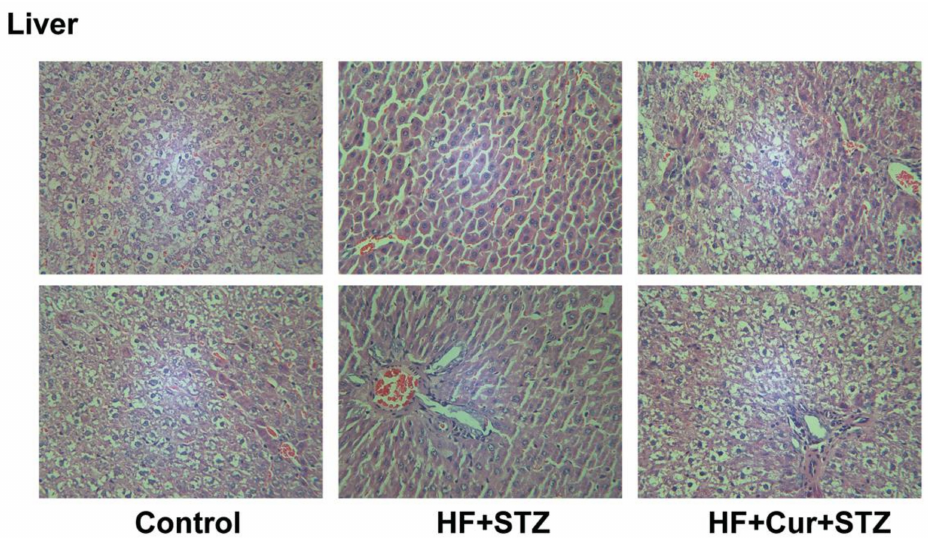
Figure 8. The e ff ect of curcumin intervention on histopathological changes in the livers of rats fed a high-fat diet then treated with